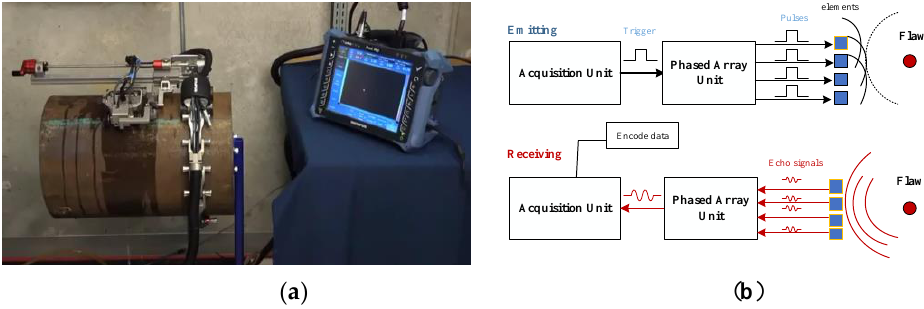
Figure 10. ( a ) Experimental apparatus; ( b ) schematic diagram of the ultrasonic phased array. Table 2. Experiment parameters.